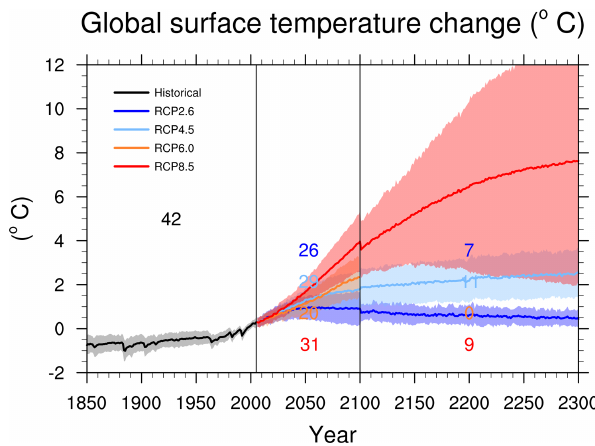
Figure 17. Time series of global annual mean surface air temper- ature anomalies (relative to 1986–2005) from CMIP5 models and RCP2.6, 4.5, 6.0 and 8.5 scenarios. The solid lines show the multi- model mean; the shading shows the 5% to 95% range ( ± 1 . 64 stan- dard deviations). The numbers indicate the number of models these estimates are based on. Similar to Collins et al. (2013) Fig. 12.5 and produced with recipe_collins13ipcc.yml (see Sect. 3.4.3 for details).